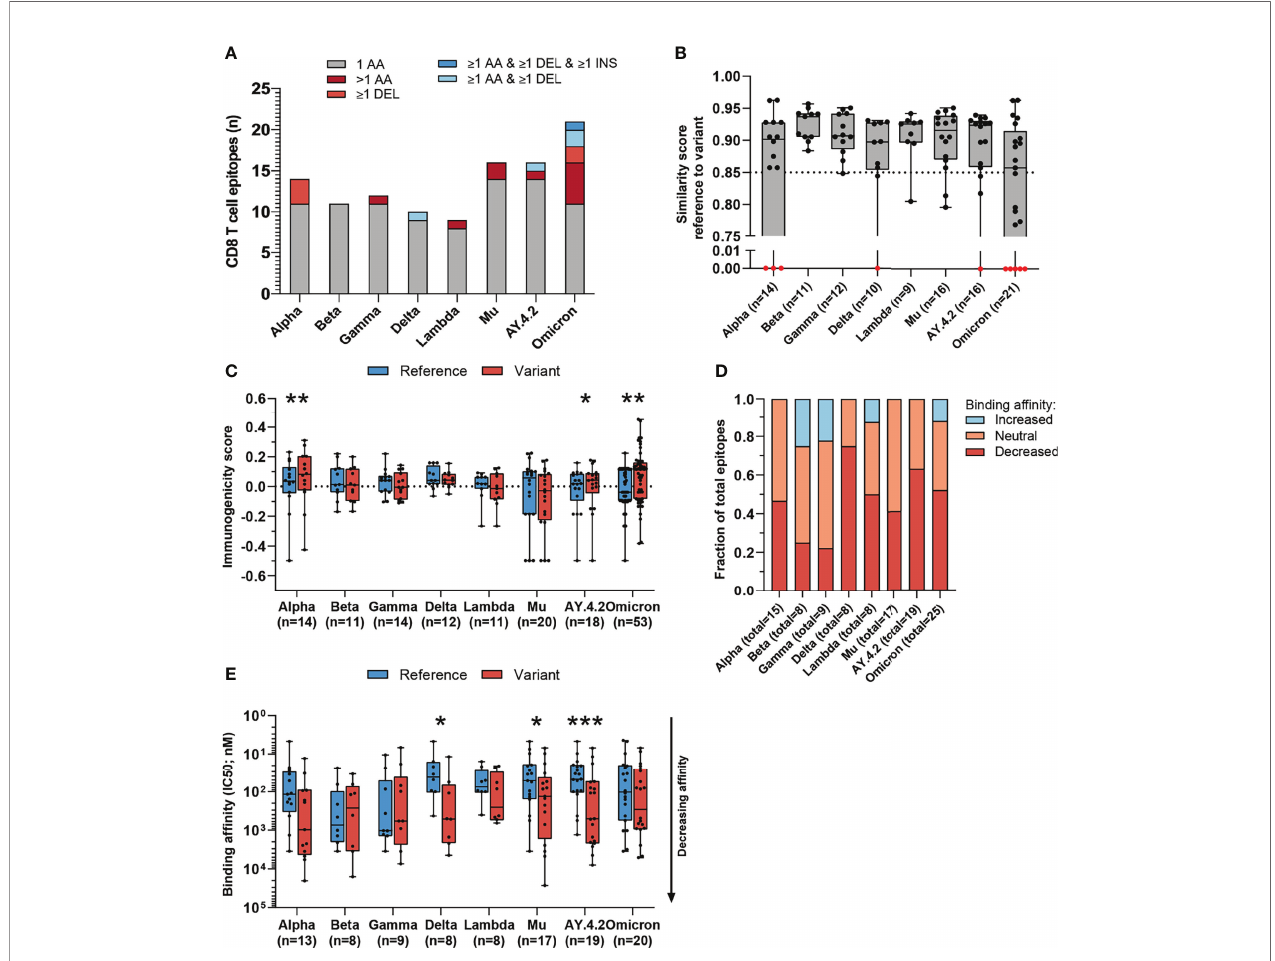
FIGURE 3 | Sequence similarity and predicted binding af fi nity of mutated CD8 T cell recognized epitopes derived from the spike protein. (A) Numbers of spike protein- derived CD8 T cell recognized epitopes per variant that harbor the indicated categories of mutations. (B) Sequence similarity scores between the spike protein-derived reference SARS-CoV-2 CD8 T cell recognized epitopes and the matched variant epitopes. Sequence similarity of epitopes in red is set to zero as a result of one or more deletions/insertions in the epitope sequence (Alpha, n = 3; Delta, n = 2; AY.4.2, n = 2; Omicron, n = 12) (C) Box plot indicating the predicted immunogenicity of the spike protein-derived reference SARS-CoV-2 CD8 T cell recognized epitopes and the altered epitopes according to the IEDB T cell class I pMHC immunogenicity prediction tool. (D) Fractions of total altered spike protein-derived CD8 T cell recognized epitopes where the predicted binding af fi nity of the epitope to the corresponding HLA restriction element was increased ( ≤ 0.5-fold change in IC50), remained neutral (0.5< fold change in IC50 <2) or was decreased ( ≥ 2-fold change in IC50) as a result of the mutation. (E) Box plot indicating the predicted binding af fi nity IC50 (nM) of the reference and altered spike protein-derived CD8 T cell recognized epitope to the corresponding HLA restriction element. Box plots indicate the median (line), 25th and 75th percentile (box), min and max (whiskers), and all data points (single circles). Statistical signi fi cance was tested with a two-tailed Wilcoxon matched-pairs signed rank test. Variation in numbers of epitopes in the analyses are due to inclusion of epitopes binding one or more HLA restriction elements. AA, amino acid; DEL, deletion; INS, insertion. *P < 0.05, **P < 0.01, ***P < 0.001. n indicates the number of epitopes analyzed per